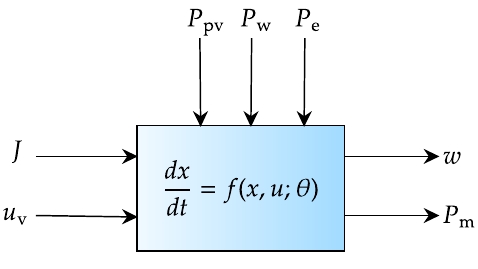
Figure 2. Functional diagram for model